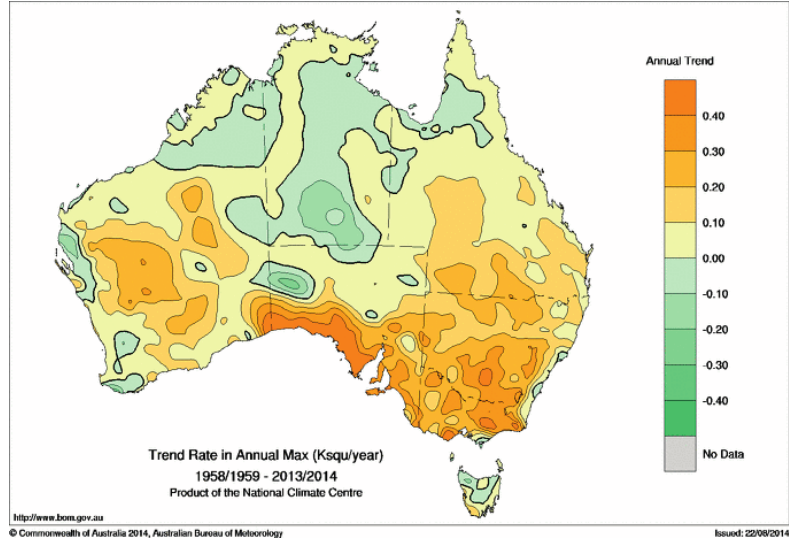
Figure 12. Trend in the annual maximum EHF across the period 1958/1959 to 2013/2014 (in K 2 /year).